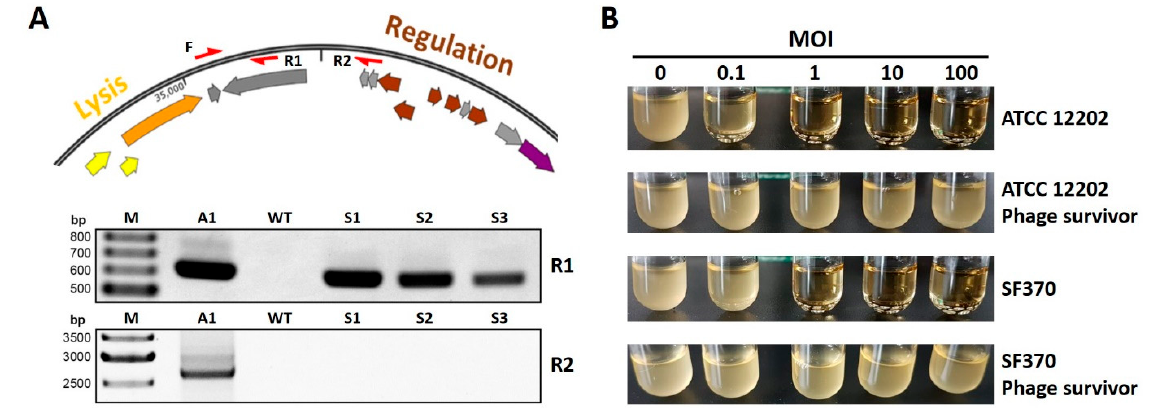
Figure 3. Phage A1 is likely a temperate phage, and Phage A1 survivors become resistant to subsequent infections. ( A , top) Genomic DNA was screened by PCR for phage integration with primers specific to Phage A1 (F + R1) and primers that should not amplify an amplicon if the Phage DNA is integrated into the genome of S. pyogenes (F + R2) (F: forward, R: reverse); ( A , bottom) Agarose gel showing PCR amplicons of both combinations F + R1 (up) and F + R2 (down) in S. pyogenes ATCC 12202. A1: Phage A1 genome, WT: wild type S. pyogenes ATCC 12202, S1: phage survivor 1, Scheme 2. phage survivor 2 and S3: phage survivor 3; ( B ) Representative pictures of S. pyogenes ATCC 12202 and SF370, and their phage-surviving strains after 4 h of infection at MOIs 0.1, 1, 10 and 100 compared to uninfected growth (MOI 0). Each image represents WT strains and one out of three phage-surviving clones that were infected in biological